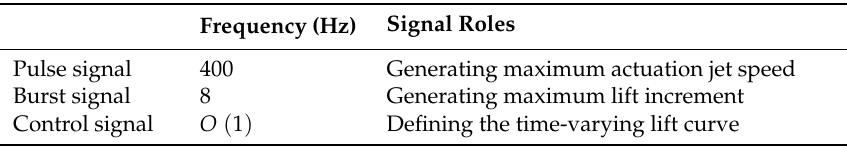
Table 1. The actuator input